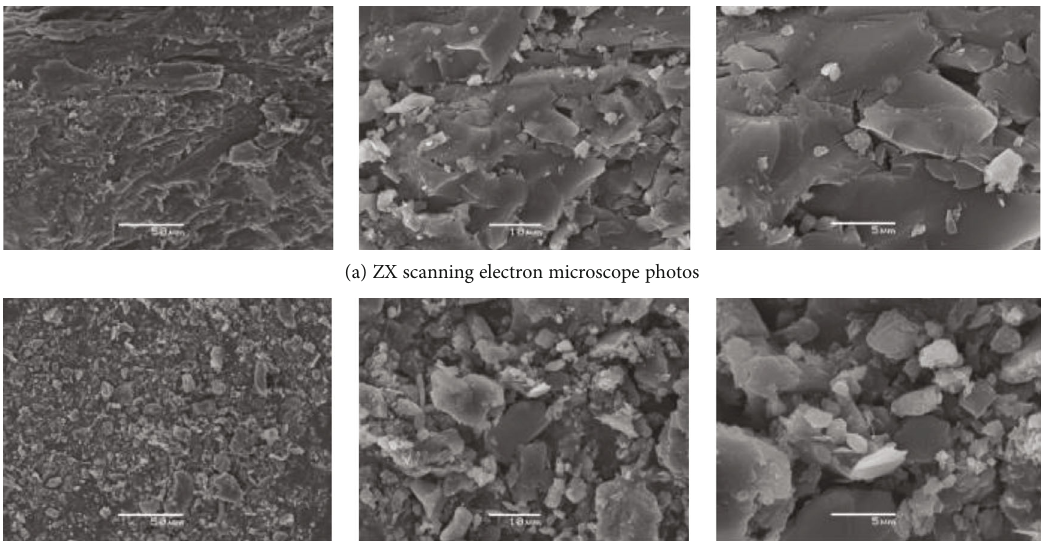
Figure 10: SEM of di ff erent types of coal fi